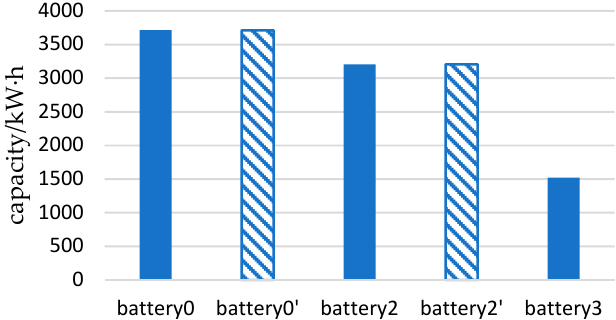
Figure 10. Capacity comparison before and after the adjacent ESS merging.